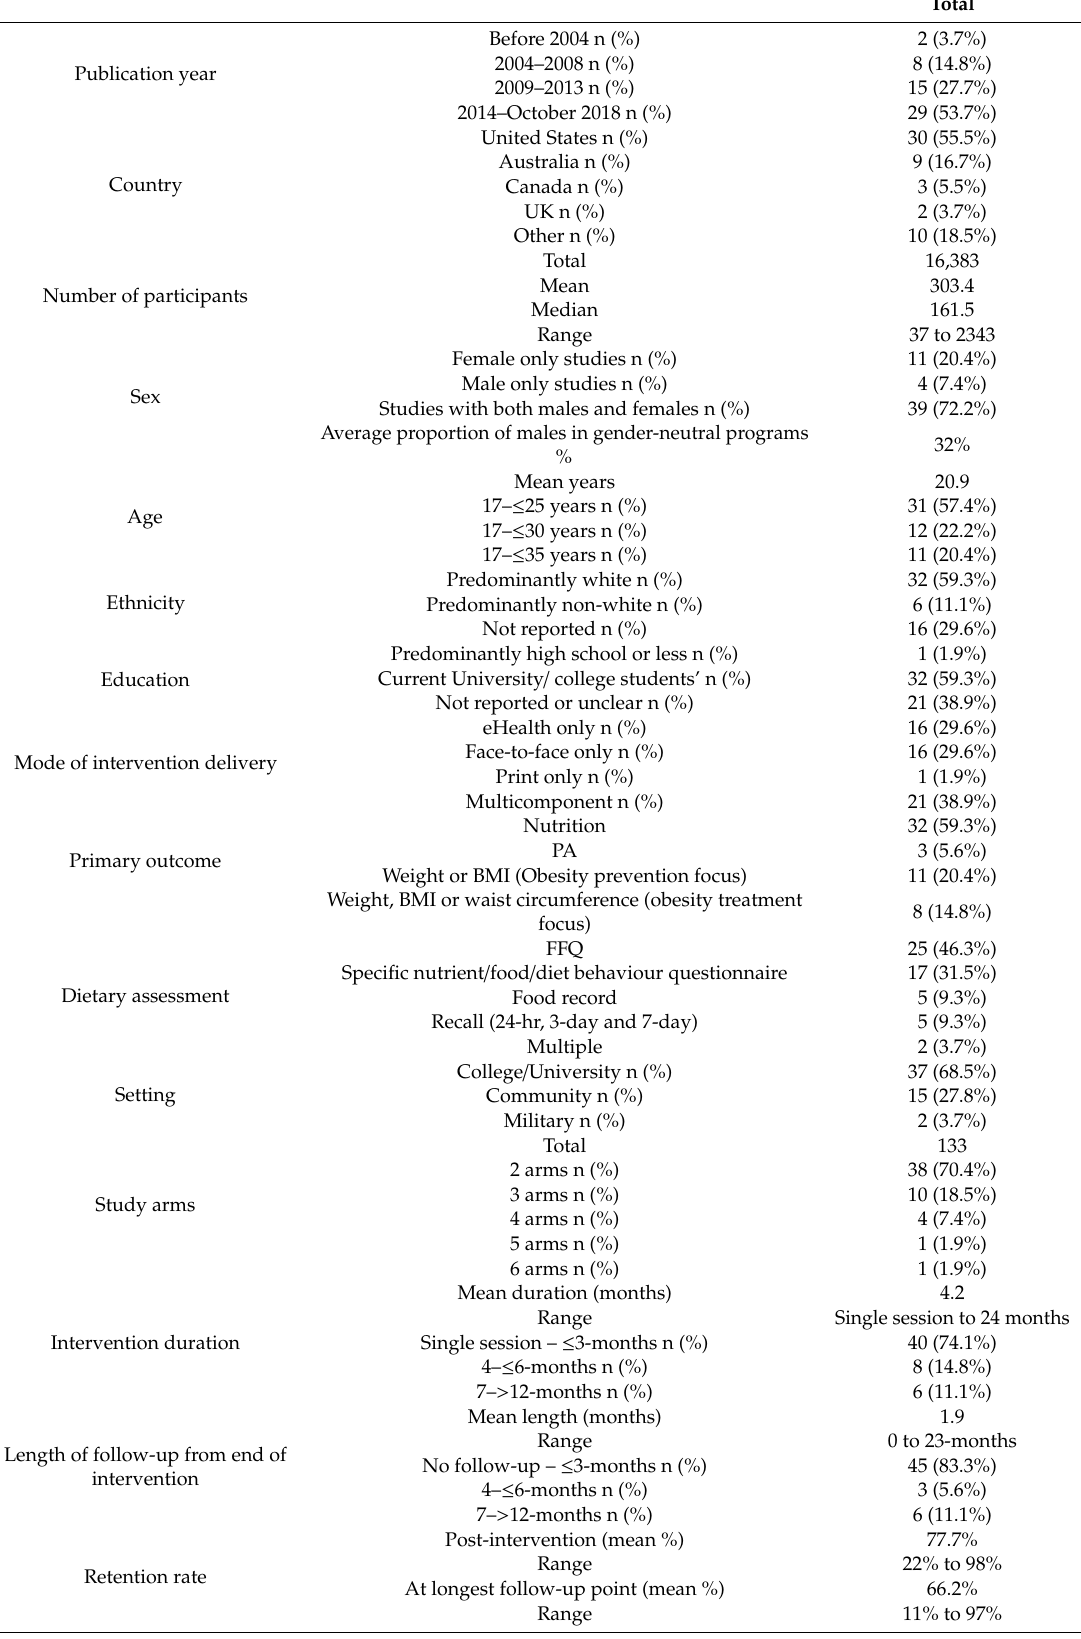
Table 1. Summary of study characteristics from 54 interventions with dietary outcome in young